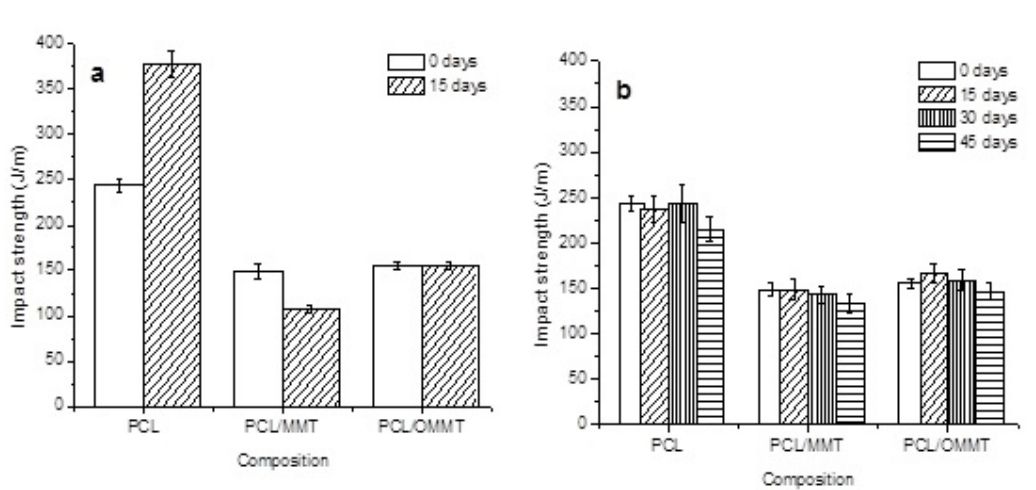
Figure 7. Impact strength of PCL, PCL/MMT and PCL/OMMT compounds upon addition of 3% w/w clay. (a) Specimens exposed to vacuum at 40oC; (b) specimens immersed in water at 40oC. Degradation time indicated.